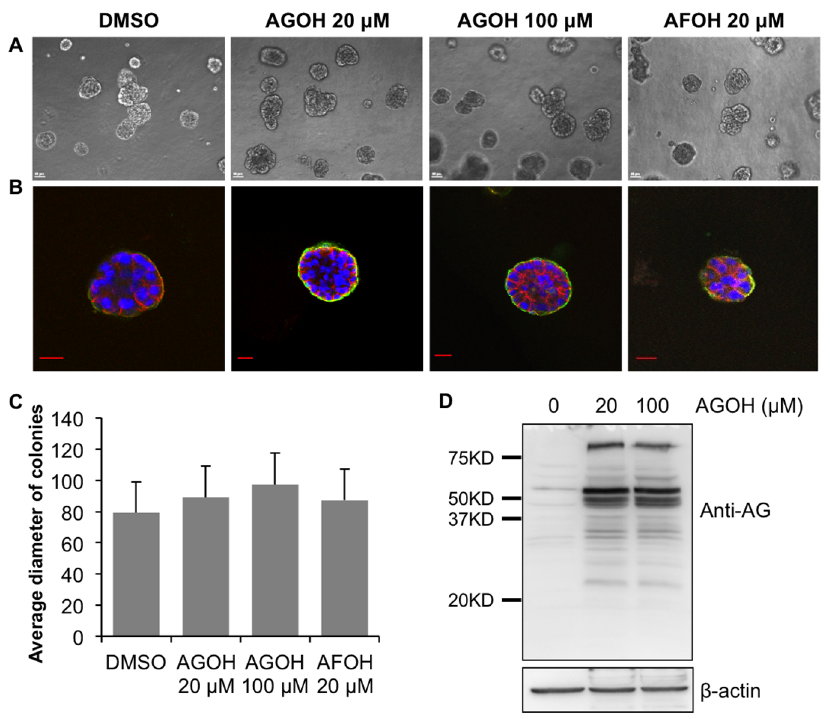
Figure 9. AGOH and AFOH do not affect 3D growth of MCF10A cells. MCF10A were seeded in Matrigel and treated with AGOH and AFOH at the indicated concentrations for 14 days. Then the phase contrast images (A) were taken from randomly chosen fields. Matrigel-containing colonies were smeared and immunostained for integrin a 6 (green), E-cadherin (red) and nuclei (blue) (B). Diameter of 60–80 individual colonies was measured and averaged in each condition (C). Cells were treated with AGOH for 3 days, harvested in RIPA buffer, and immunoblotted with polyAG antibody (D). Representative images from at least three separate experiments are shown. Scale bars in phase contrast equal 50 m m and in confocal images represent 20 m